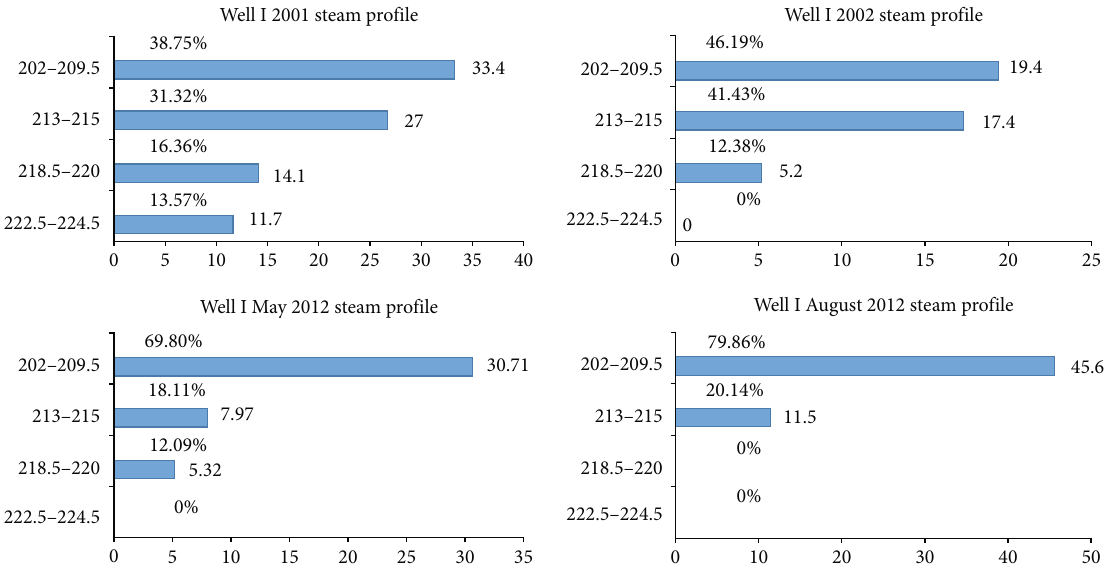
Figure 2: Variation in the steam absorption pro fi les of well I in the Xinjiang J6 block [7, 9].